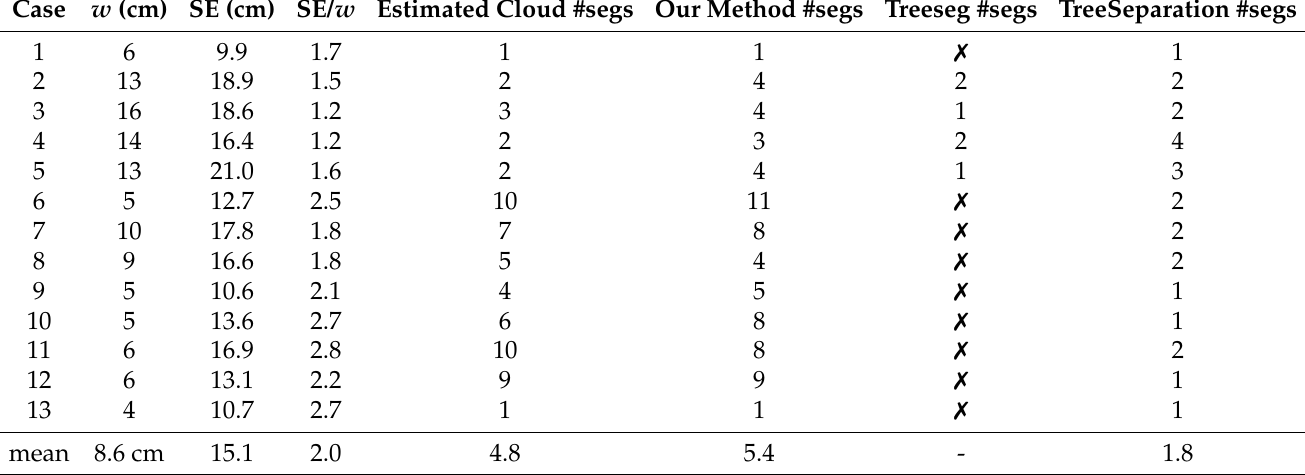
Table 3. Quantitative comparison. For each case in Tables 1 and 2 and we present the Surface Error (SE) of our method to its point cloud, and compare the principle number of stems reconstructed with the number of segments produced from the popular Treeseg and TreeSeparation algorithms. Failed functions are marked with (cid:55) .